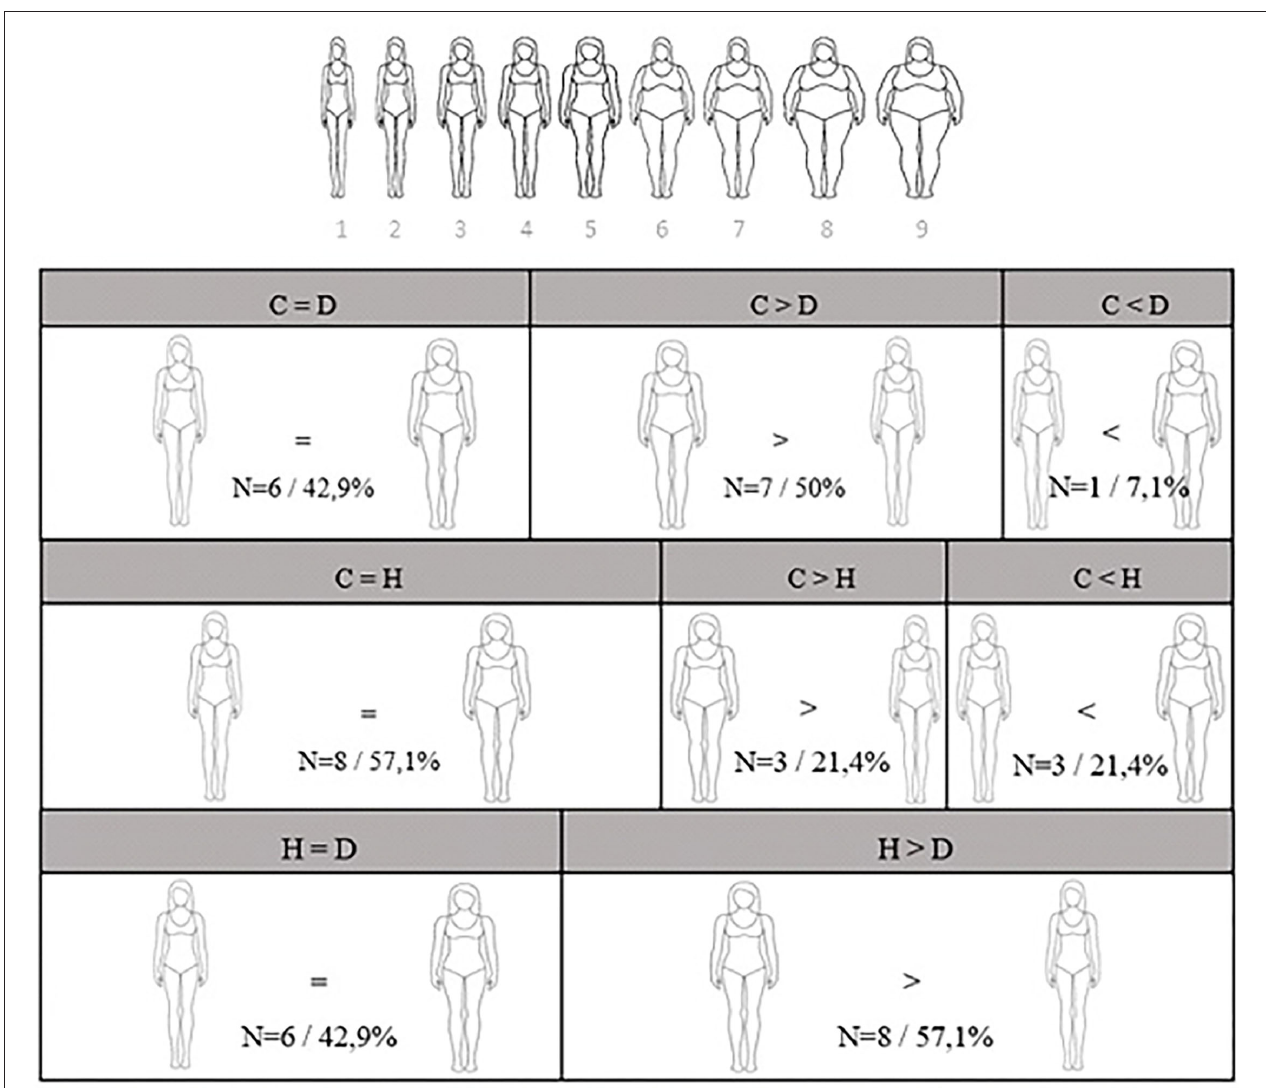
FIGURE 1 | Frequency of reporting in different Stunkard’s Scale categories. C, current body shape; D, desirable body shape; H, Healthy body shape. Images adapted from Stunkard’s